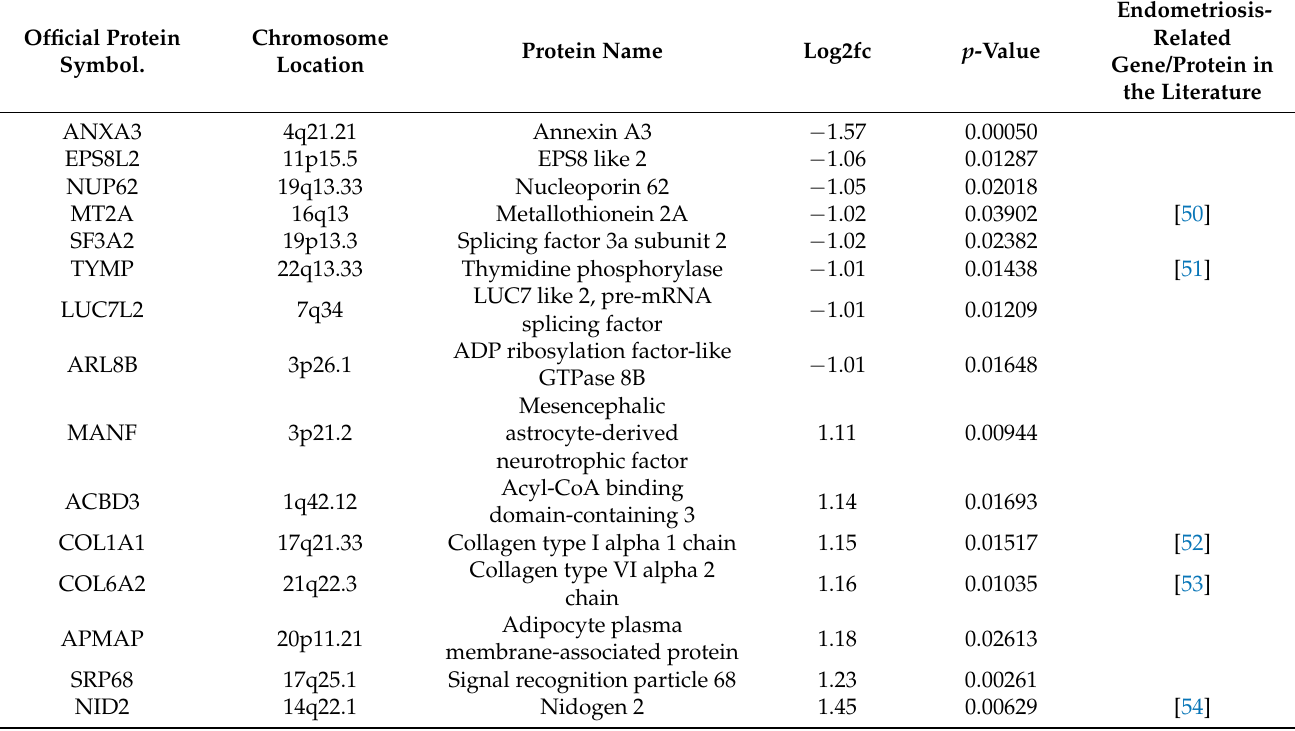
Table 2. Differential expression proteins (DEPs) in endometriosis MenSCs and endometriosis-related genes/proteins in the